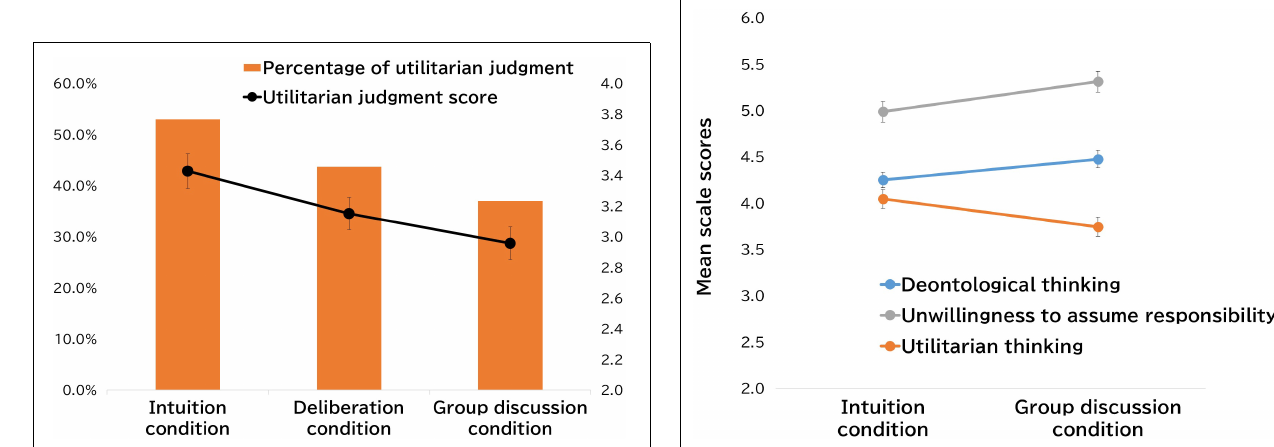
FIGURE 1 | The fickle moral judgment for the conditions using two indicators. FIGURE 2 | The change in mean scale scores regarding the trolley